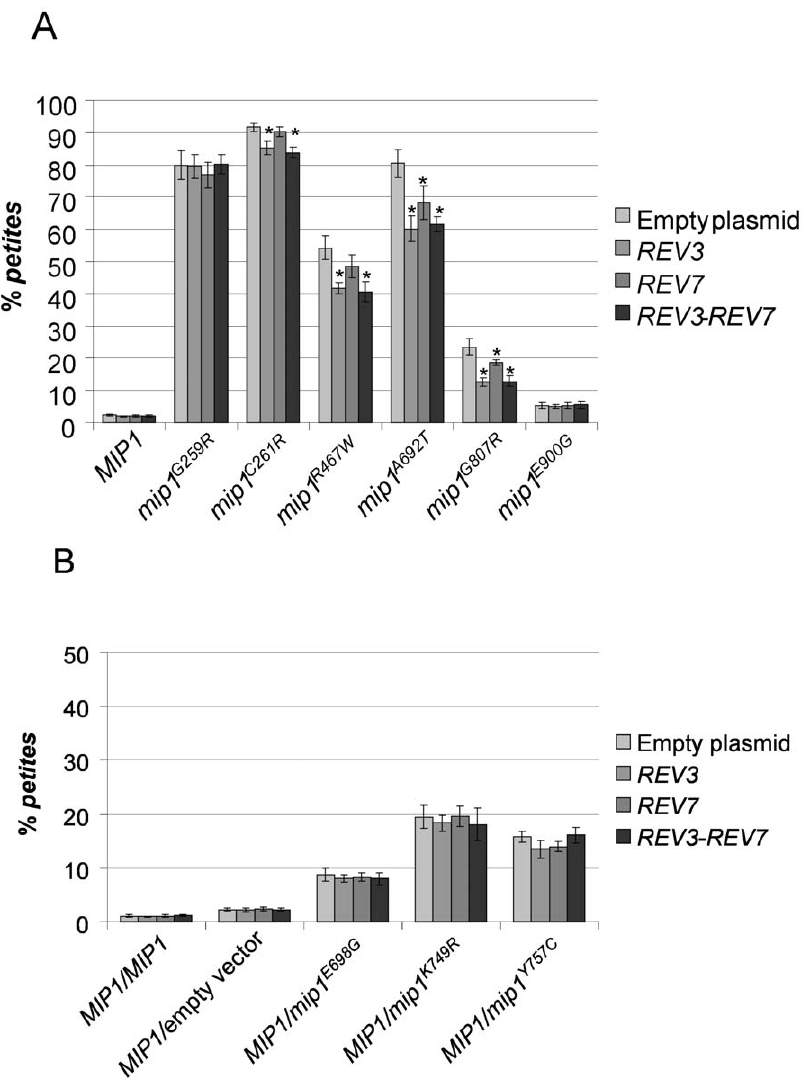
Figure 2. Petite frequency of mip1 strains overexpressing REV3 , REV7 , or both. Petite frequency was measured as reported in Materials and Methods on three independent clones for each strain. All values are means at least of three independent experiments. (A) Haploid mutant strains harboring mip1 recessive mutant alleles. (B) Heteroallelic strains harboring MIP1 wt allele and mip1 dominant mutant alleles. For each mip1 allele, * indicates that the petite frequency is significantly lower (p , 0.05) than that of strain transformed with the empty plasmid (YEplac195).